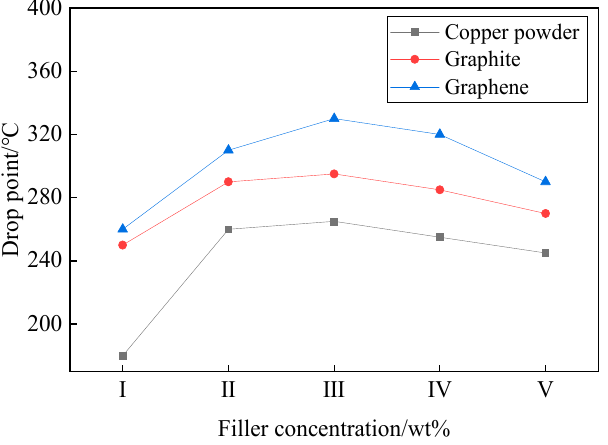
Figure 8. Different filler concentration–dropping point relationship.